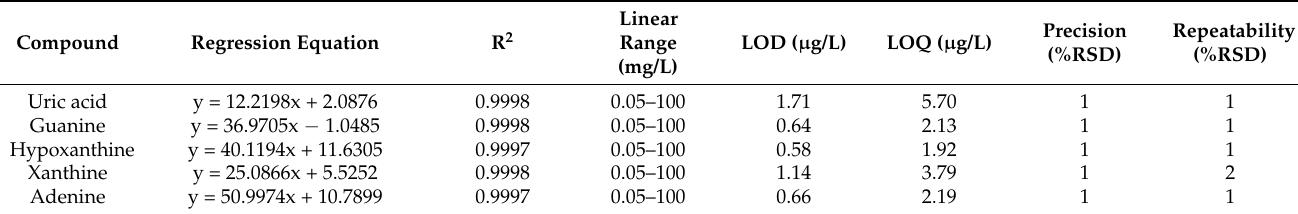
Table 3. Calibration curves, limits of detection (LODs), limits of quantification (LOQs), precision and repeatability for the four purines and uric acid using the optimized HPLC method ( n = 6).